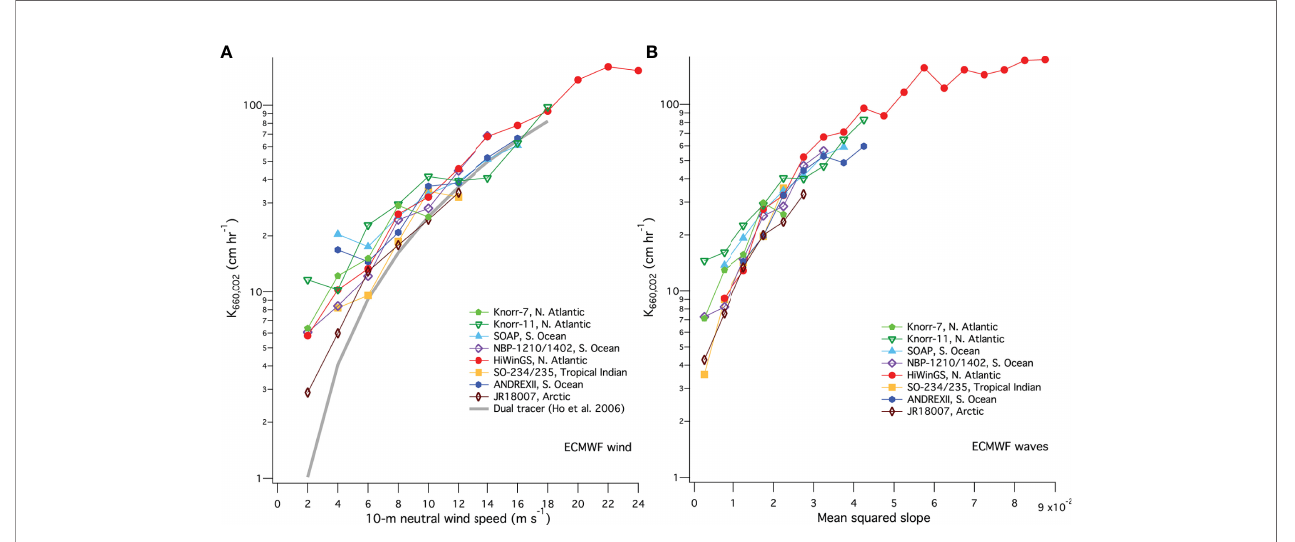
FIGURE 7 | (A) K 660 averaged into bins of ECMWF U 10n ; (B) K 660 averaged into bins of ECMWF mean squared slope